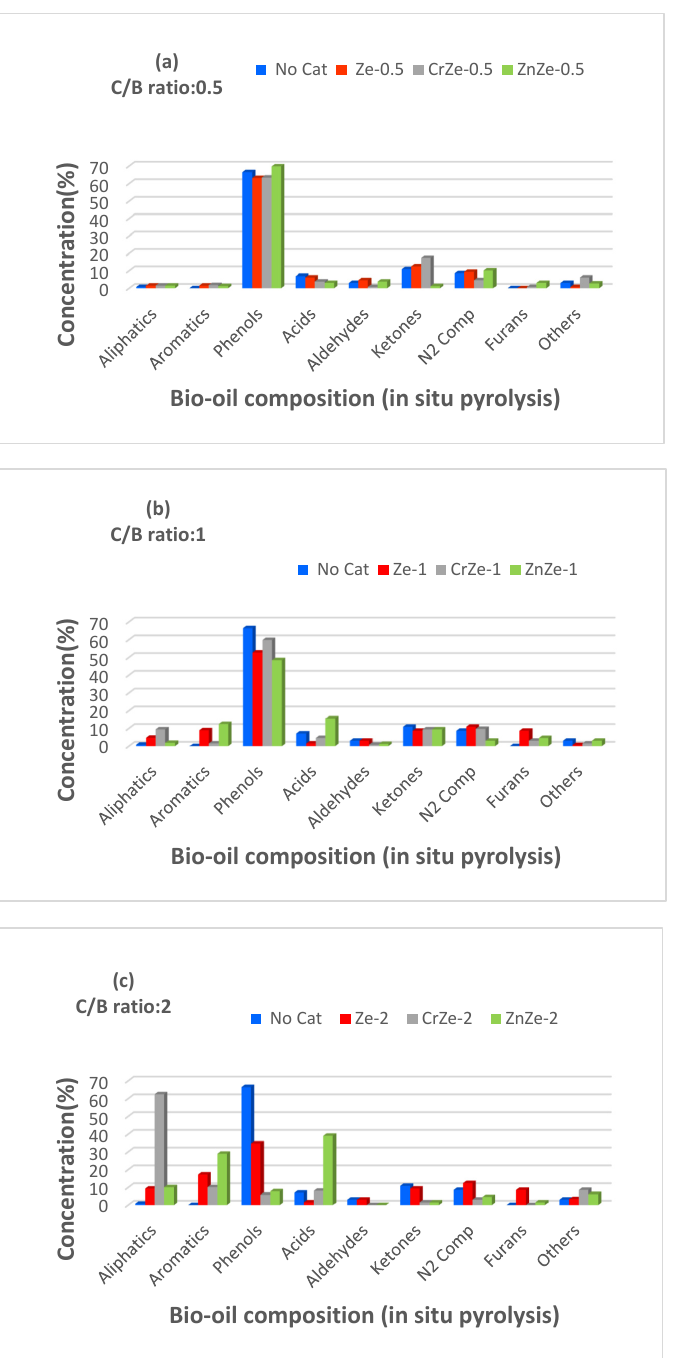
Figure 8. Bio-oil composition resulted by in situ pyrolysis of PTCCB; ( a )—catalyst-to-biomass ratio was 0.5; ( b )—catalyst-to-biomass ratio was 1; ( c )—catalyst-to-biomass ratio was 2 (see Table 1).